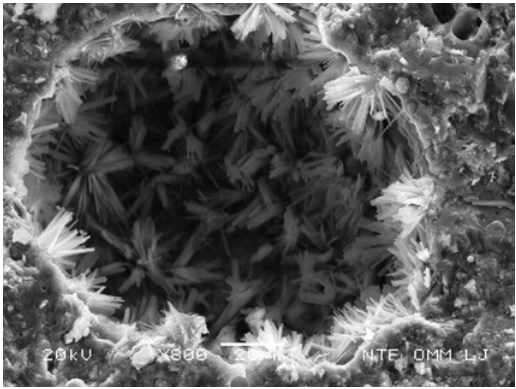
Figure 7 Micro fractography of the sample BI-DT microcrack with ettringite crystals; SEM,